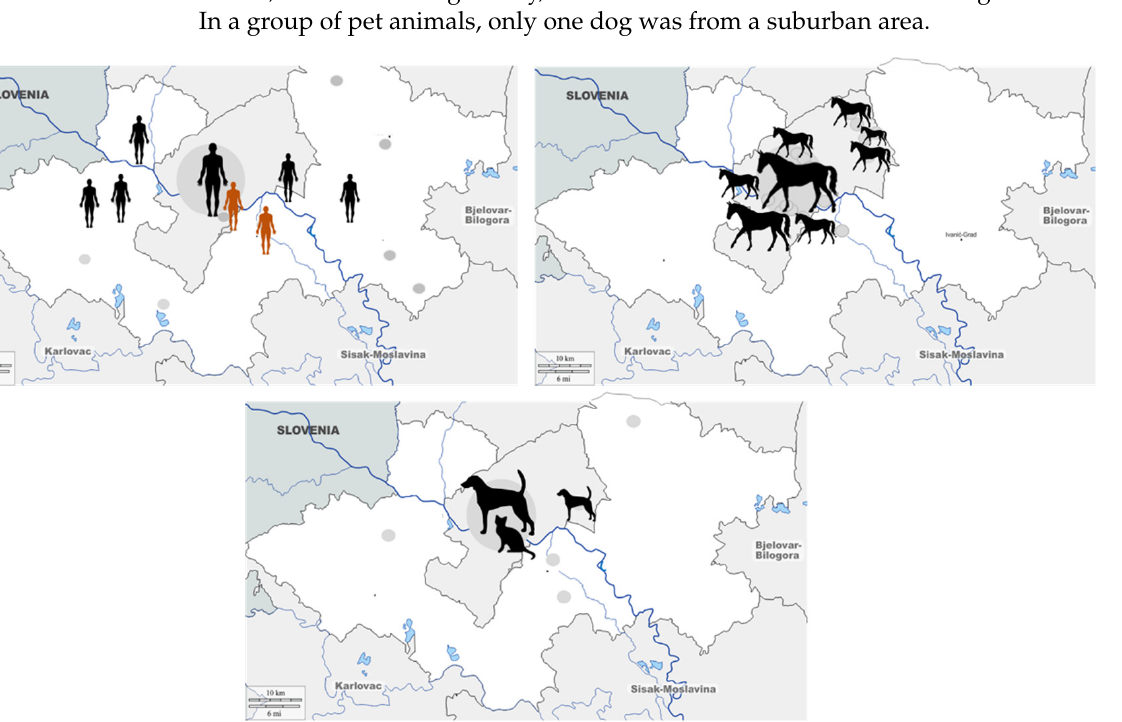
Figure 3. Geographic distribution of Tahyna virus seropositive humans, horses, and pet animals. (symbol size represents the number of cases)